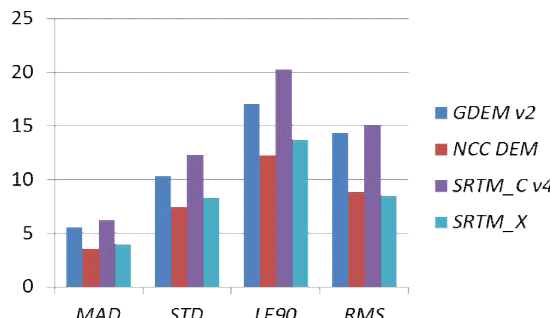
Figure 3: Accuracy assessment of reference height models with ICESat